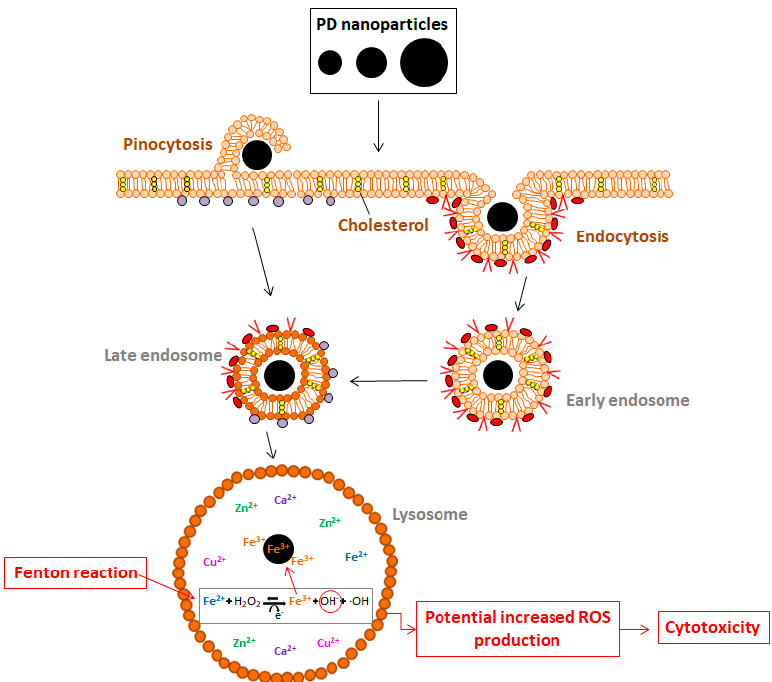
Figure 5. Schematic representation of the mechanism that could explain how PD NPs could be responsible for a reduction in cancer cells’ viability after their cellular internalization in lysosomes.